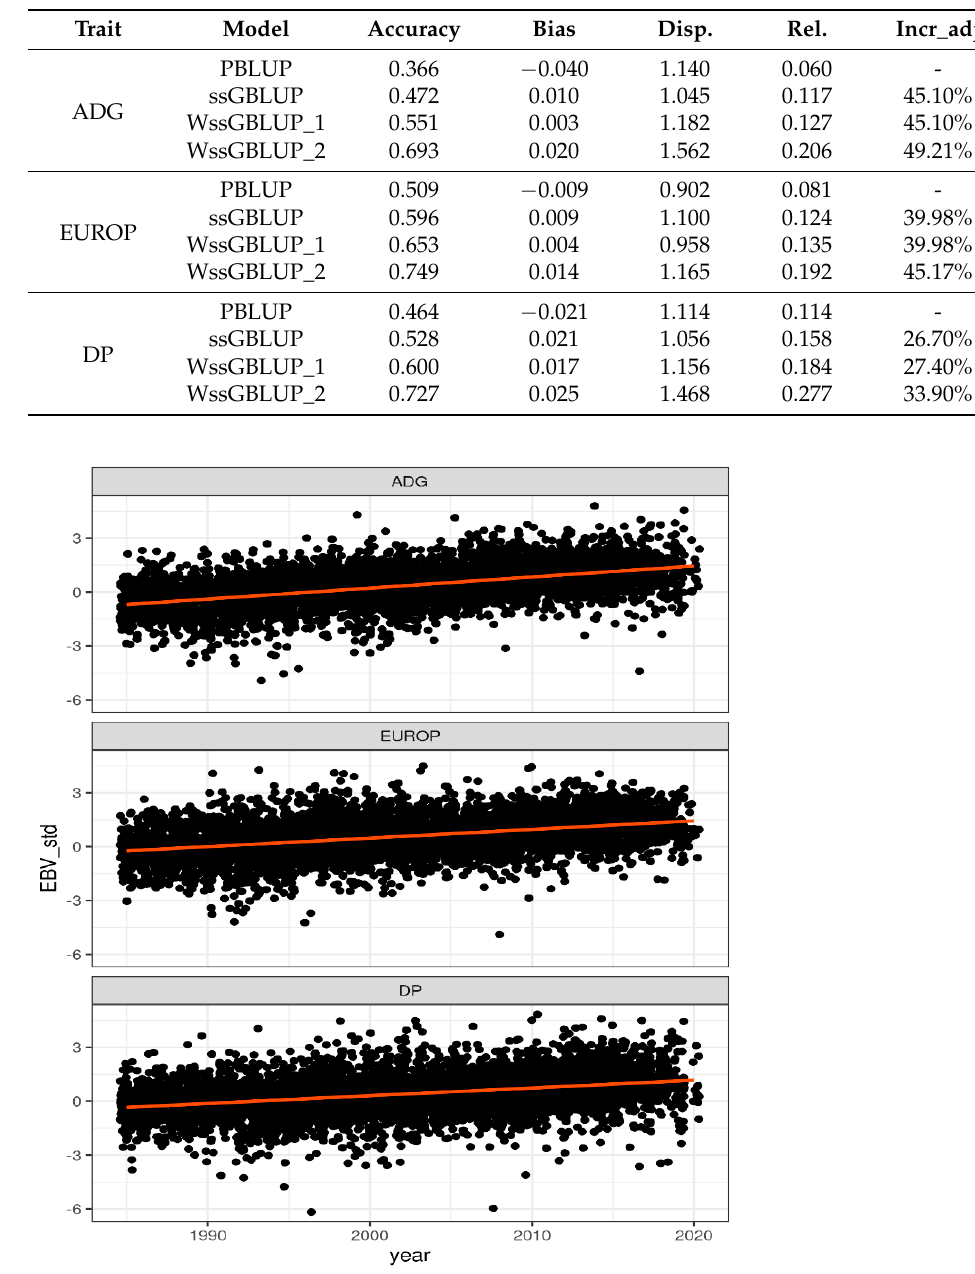
Figure 6. Standardize genetic progress per year: x-axis indicates birth year of animals and y-axis the standardized EBV, from 1985 (when performance test started) to 2020 (current data).